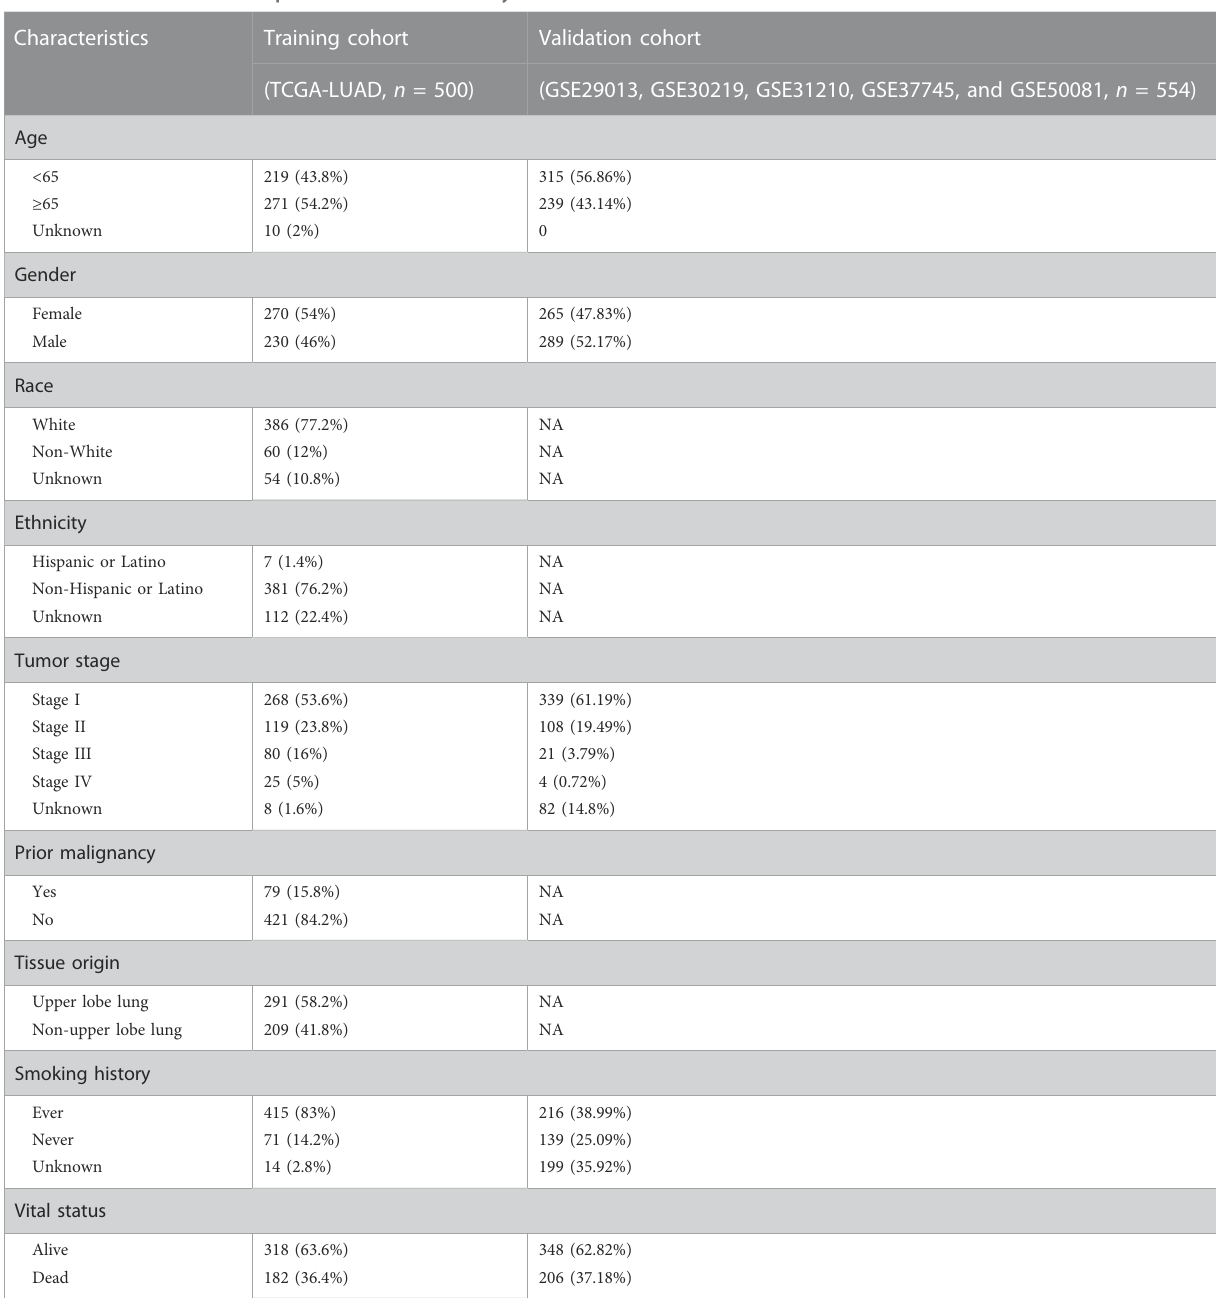
TABLE 1 Clinical characteristics of patients enrolled in the study. Characteristics